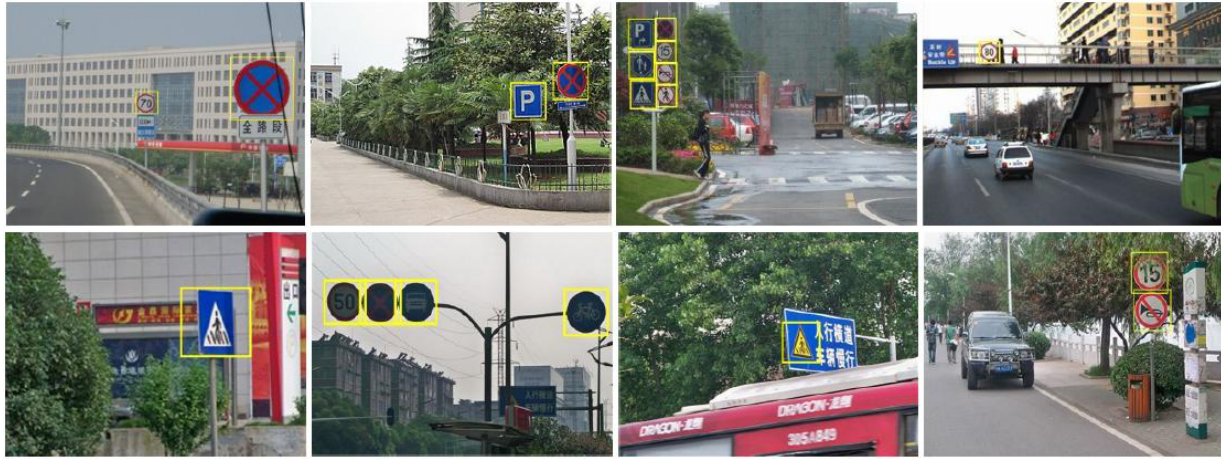
Figure 13. Detection of traffic signs under various